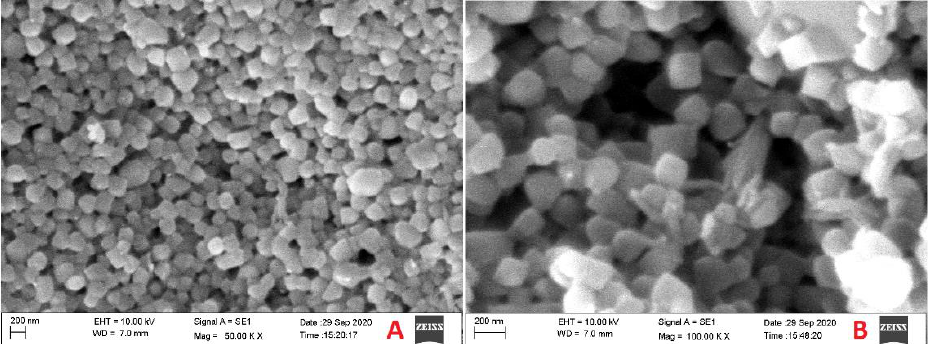
Figure 7. Scanning electron microscopic images of MIL-101(Fe) ( A , B ) depict different magnification levels.